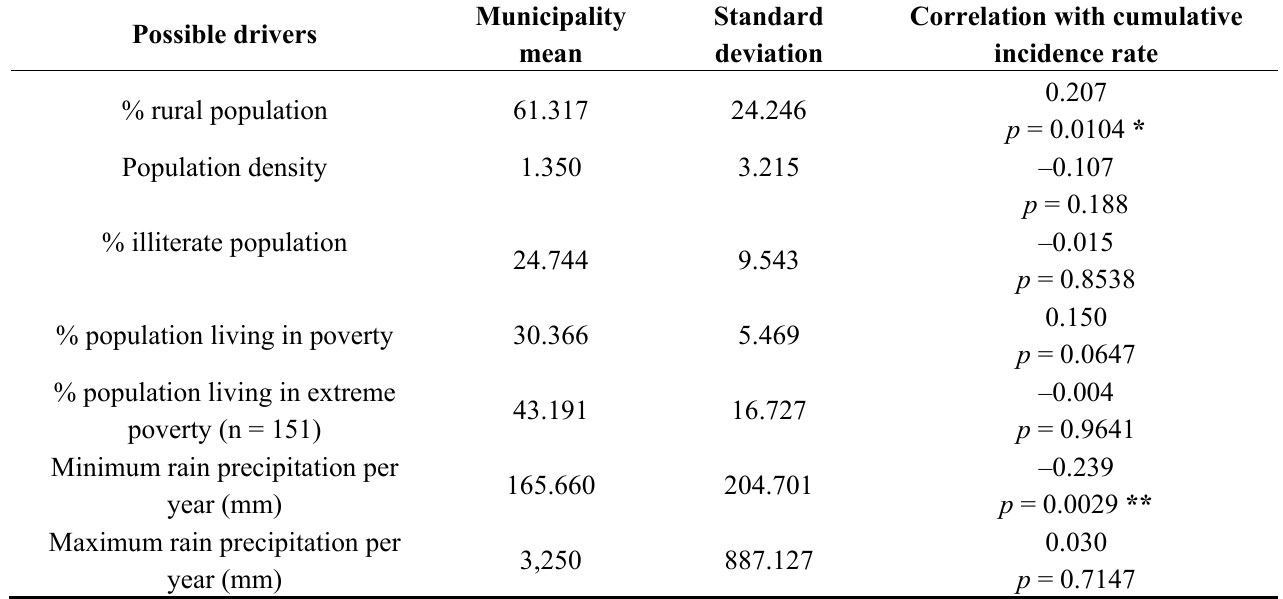
Table 4. Municipality mean, standard deviation, and correlation among selected possible drivers and cumulative incidence rate (10,000 populations),